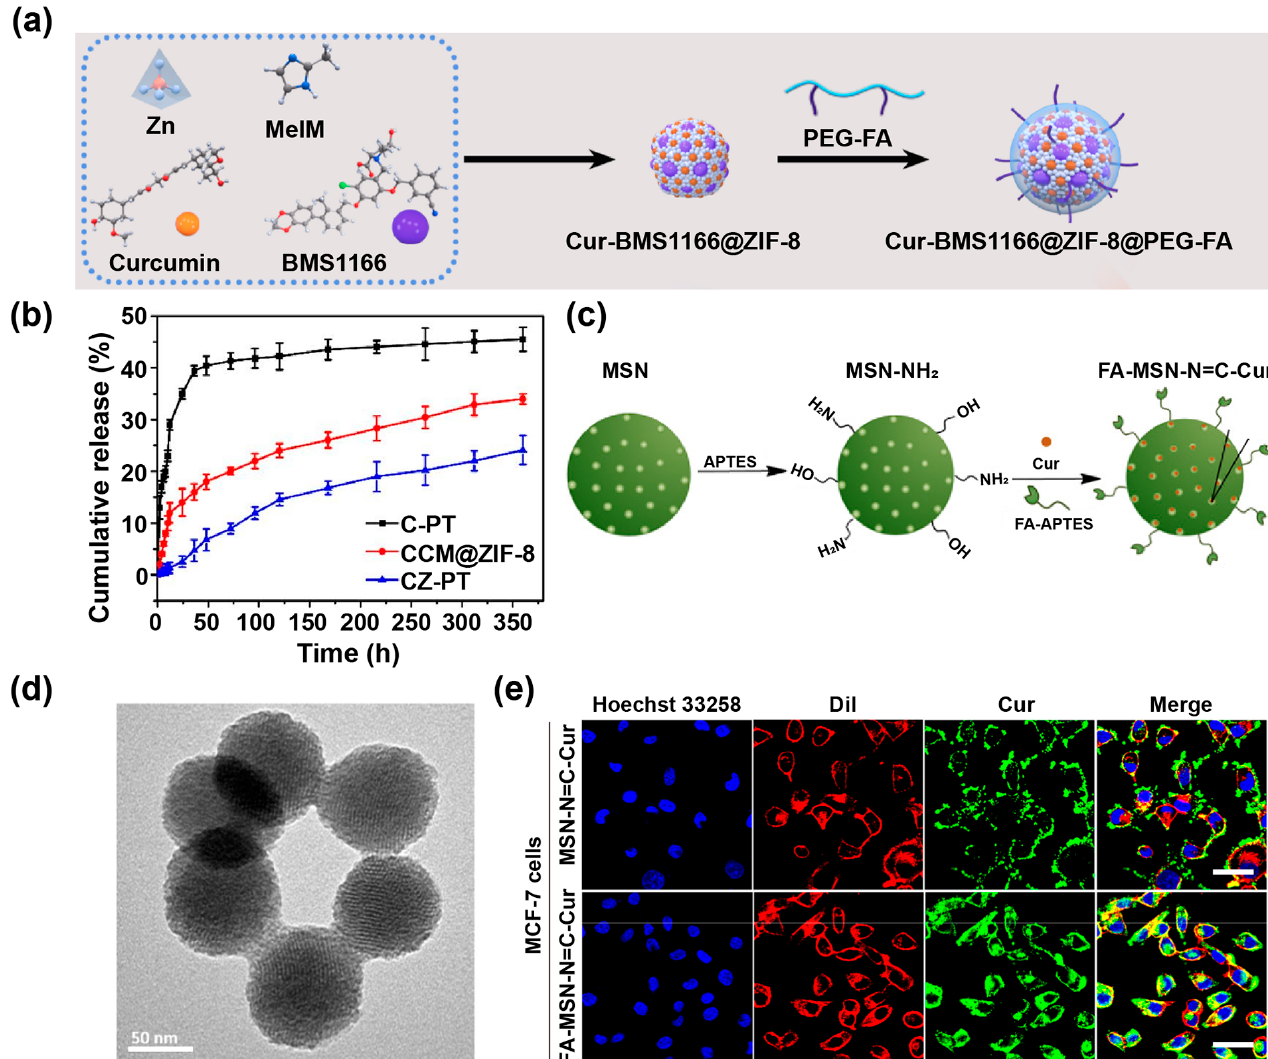
Figure 2. ( a ) Schematic diagram of the preparation of Cur-BMS1166@ZIF-8@PEG-FA. Reproduced with permission from [39], Copyright 2022, Elsevier. ( b ) Cur release from CCM@ZIF-8, C-PT and